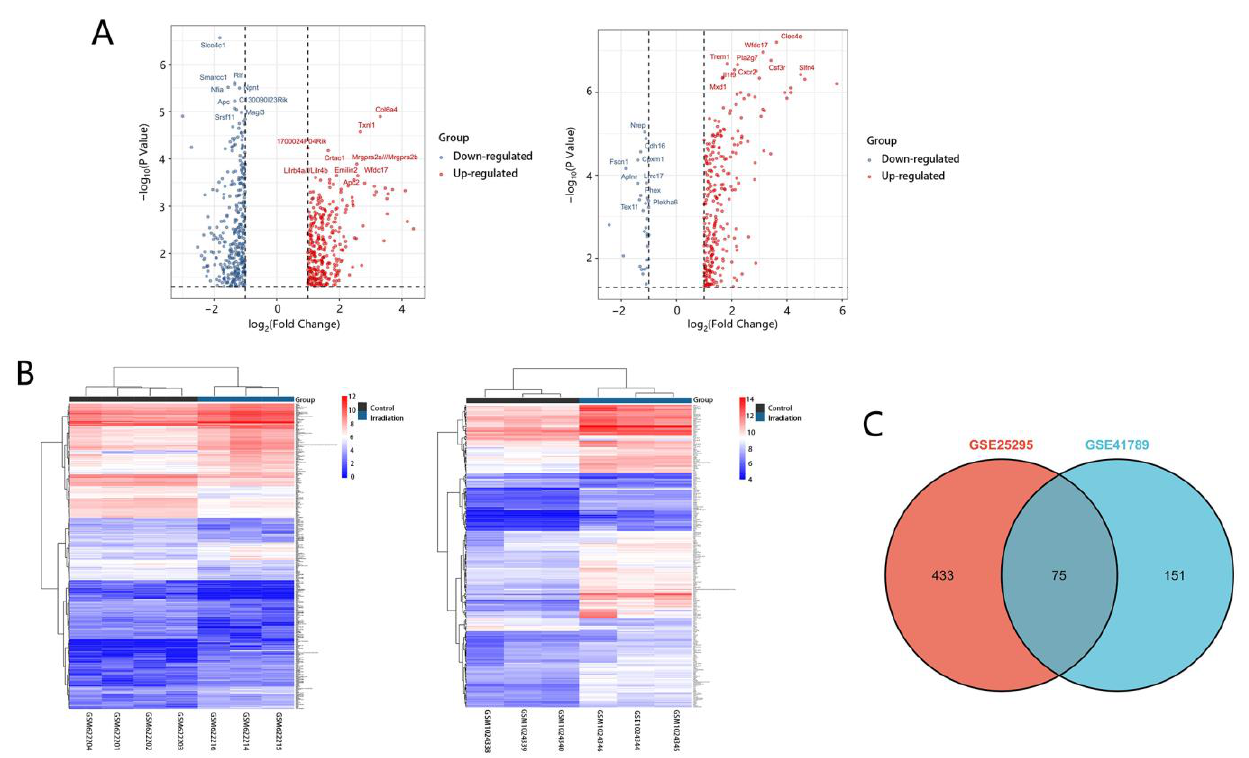
Figure 1. Volcano plots, heatmap and Venn of DEGs. ( A ) Volcano plot analysis identifies DEGs. Red dots represent up-regulated genes and green dots represent down-regulated genes. The differences are set an |log FC| > 1. ( B ) Heatmap of DEGs identified in two datasets. Red areas represent highly expressed genes and green areas represent lowly expressed genes. ( C ) Venn diagram of common DEGs from the two datasets. There are 75 common DEGs in the two datasets.